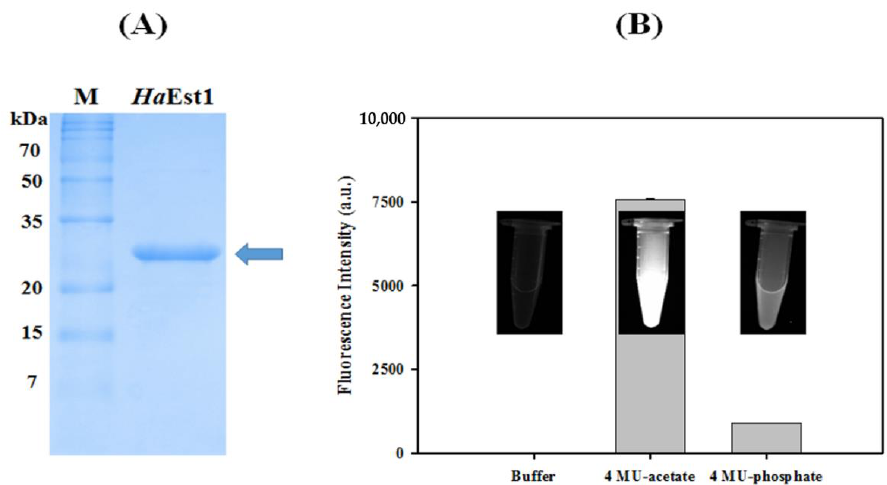
Figure 2. Purification and hydrolytic activity of Ha Est1. ( A ) SDS-PAGE analysis of Ha Est1. Arrow indicates the position of purified Ha Est1. ( B ) Hydrolysis of 4-MU acetate was examined with Ha Est1. Strong fluorescence was observed due to hydrolysis reaction by Ha Est1.